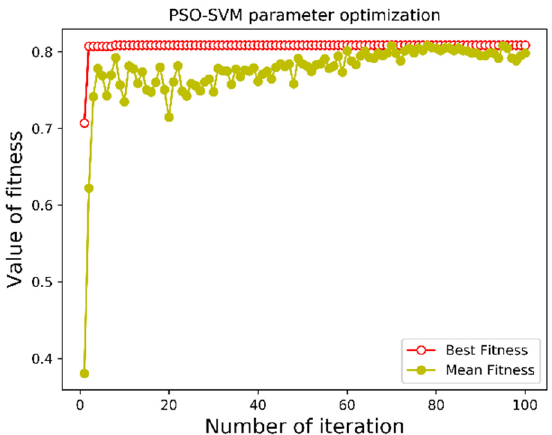
Figure 8. Diagnosis accuracy of PSO-SVM algorithm.